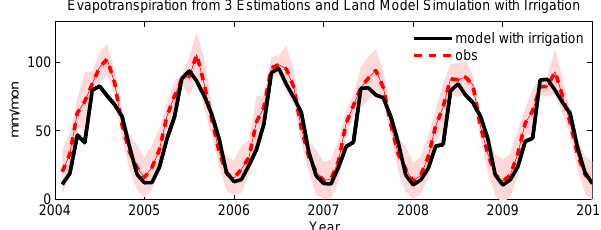
Figure 6. Monthly ET from CLM 4 with the improved irrigation parameterization when compared to observations. Lines indicate model or ensemble mean while shading indicates uncertainty of the satellite-observed ET.